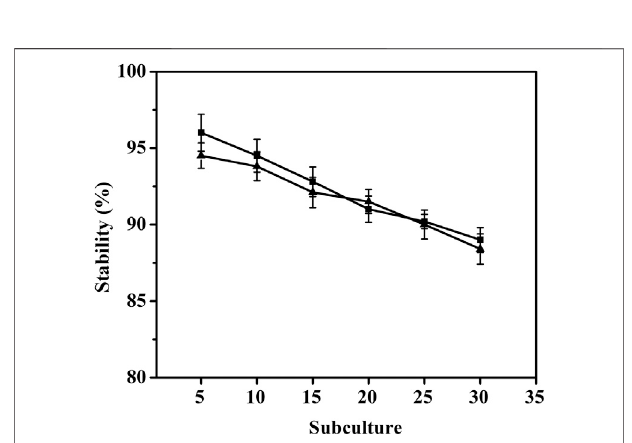
FIGURE 4 | Stability of the vector pMI-4. Filled square ( ■ ) represents C. glutamicum /pMI-4, and fi lled triangle ( ▲ ) represents C. glutamicum /pXMJ19.